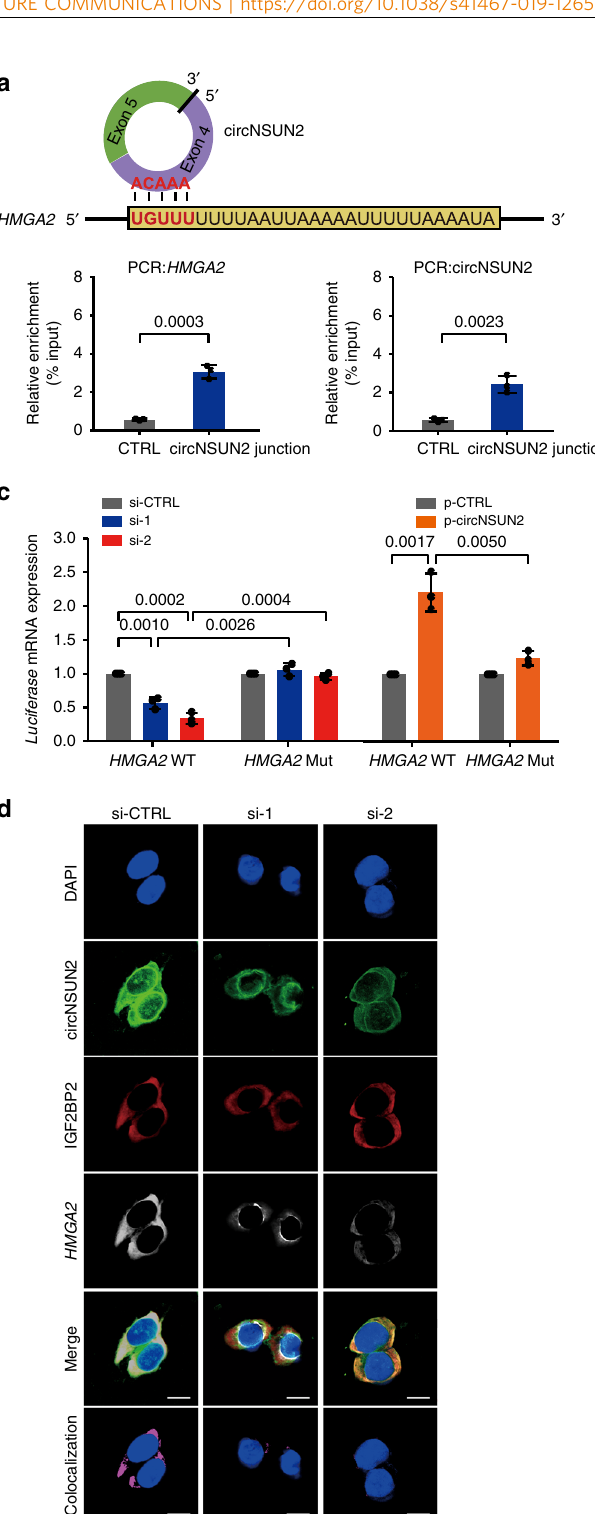
(Fig. 6c, right) of HMGA2 -WT, but not that of HMGA2 -Mut. Conversely, overexpression of circNSUN2 dramatically increased the luciferase mRNA expression (Fig. 6c, left) and luciferase activity